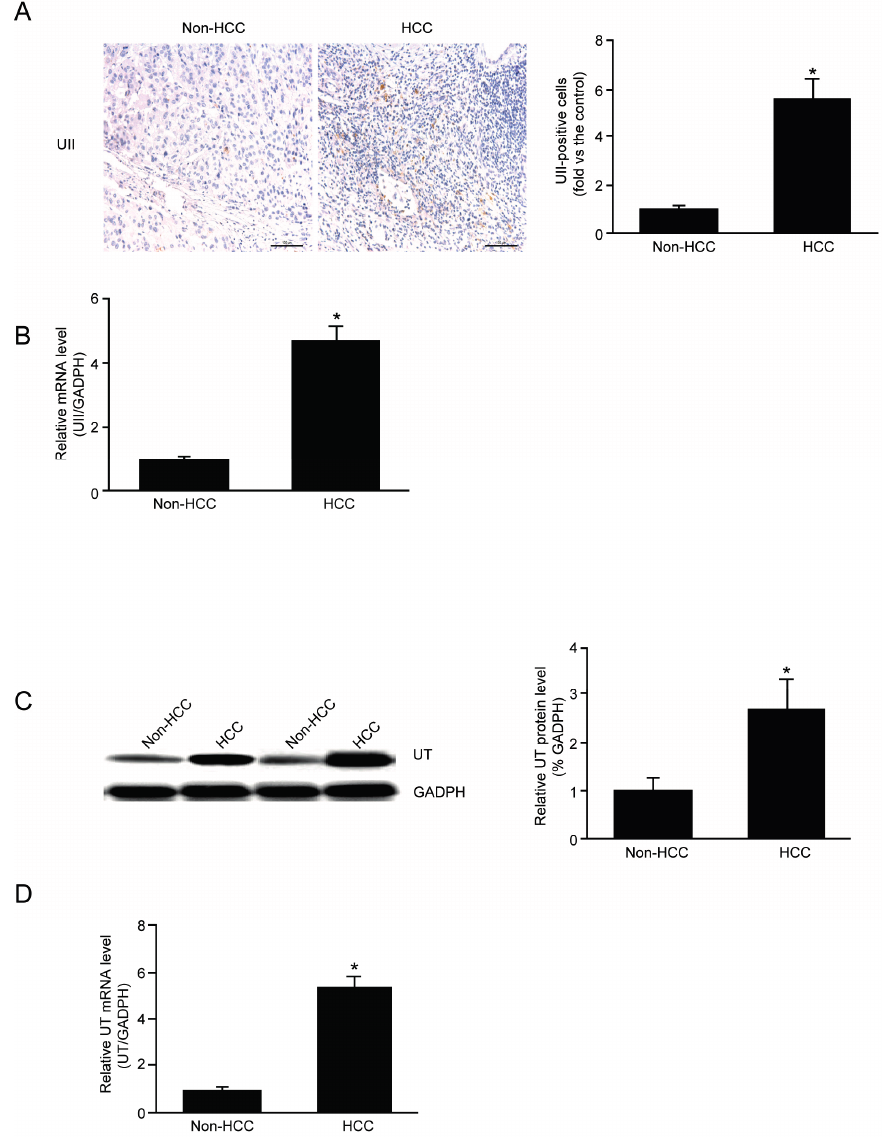
Figure 2. UII/UT mRNA and protein expression in non-HCC and HCC tissues. ( A ) Analysis of UII protein expression by immunohistochemical staining; ( B ) Quantitative analysis of UII mRNA expression by qPCR; ( C ) Analysis of UT protein expression by western blotting; ( D ) Quantitative analysis of UT mRNA expression by qPCR. Data are mean ± SE ( n = 8, * p < 0.05 compared with